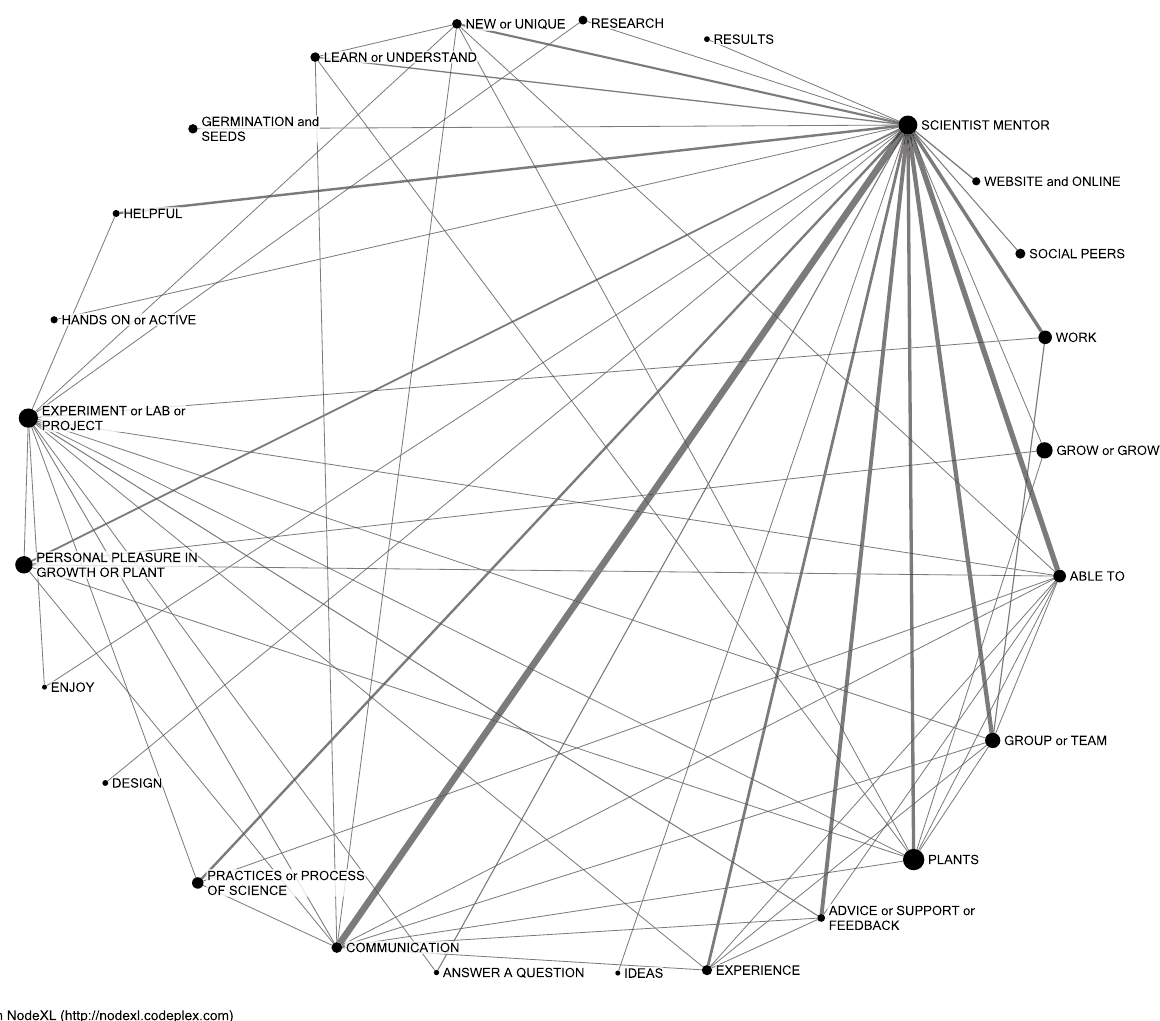
Figure 3. Lexical web illustrating connections of students’ comments about liking their mentors to other favored elements. The size of the node represents the number of total respondents liking that element, and the width of the line between nodes is weighted by the number of shared responses. Items with fewer than 20 respondents are filtered out to simplify the lexical